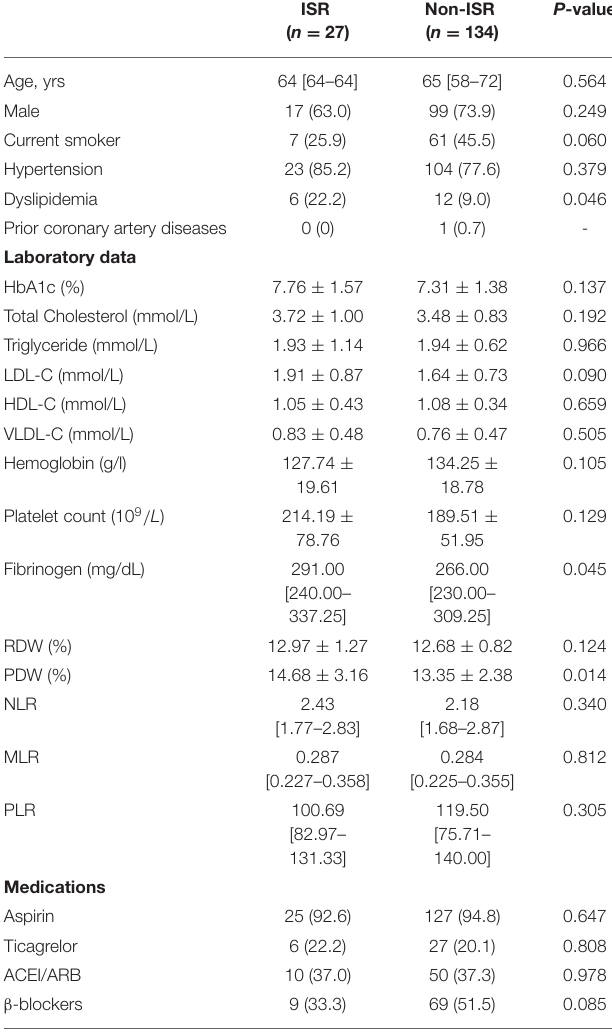
TABLE 1 | Baseline clinical